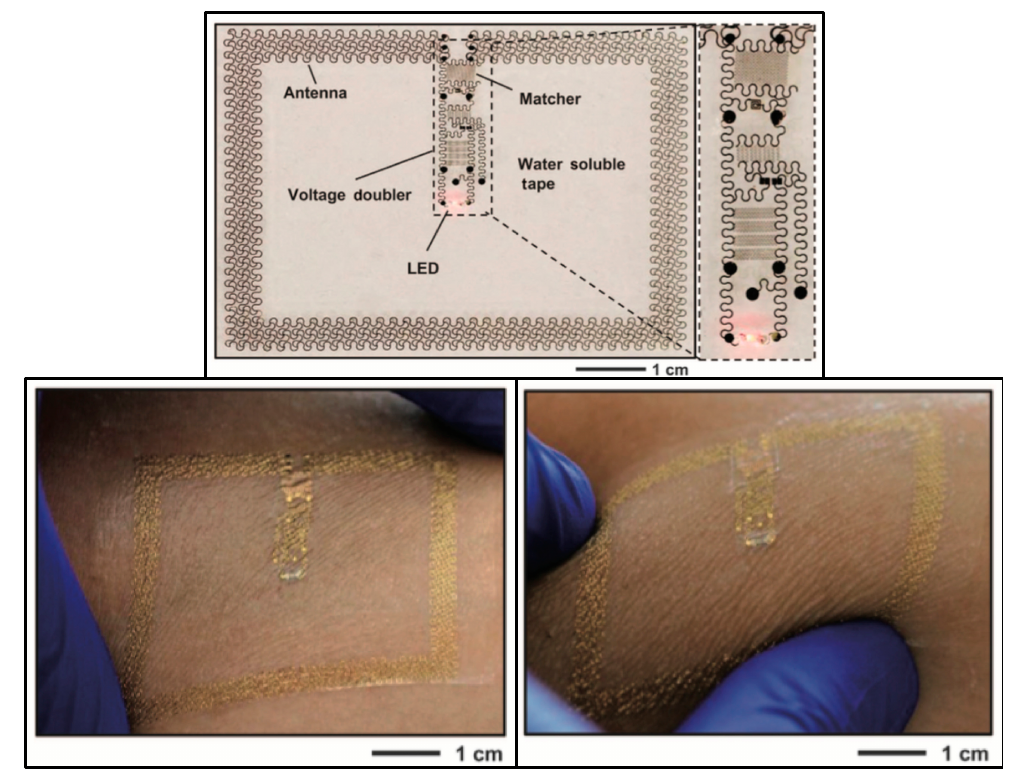
Figure 5. Photograph of the wearable wireless device with the LED turned on ( top ) and photographs of the device attached to skin and squeezed ( bottom ). Reproduced with permission from [15].